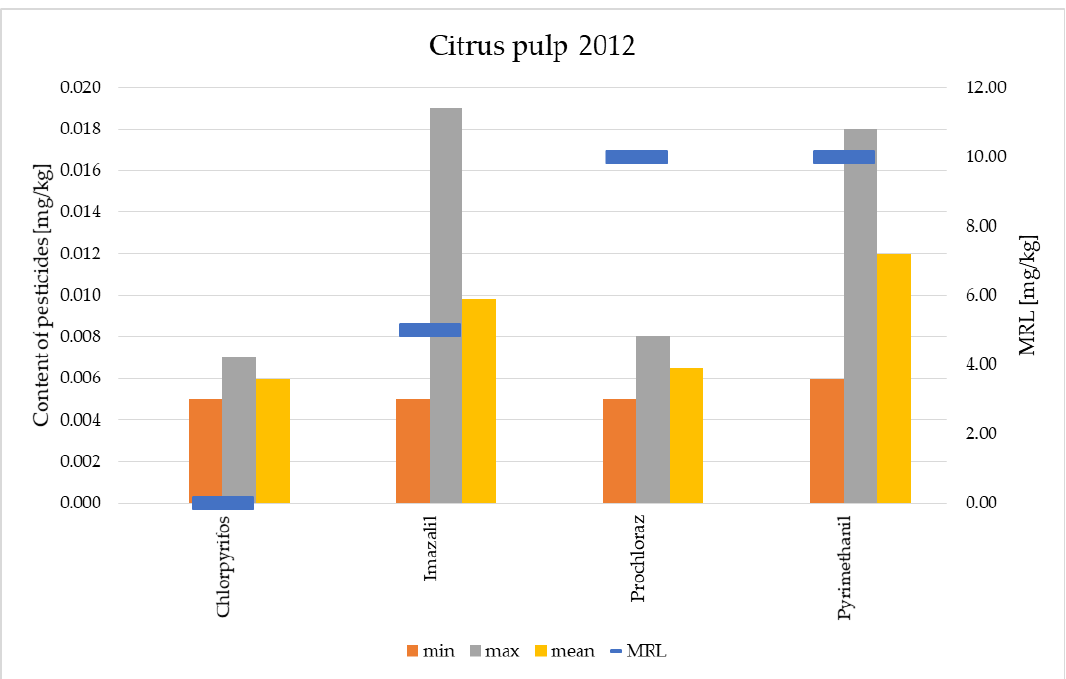
Figure 4. Content of pesticides from the edible parts of citrus fruits from the harvest of 2012.